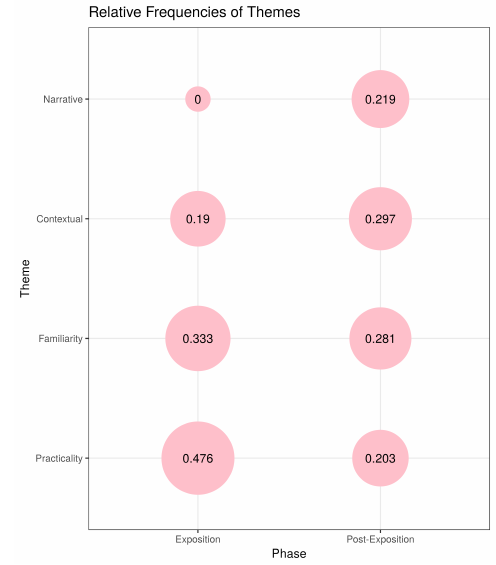
Figure 13: Relative frequencies of Themes referenced when dis- cussing Relative Closeness by Scenario Phase. Table 15: Co-occurrences in perceived closeness